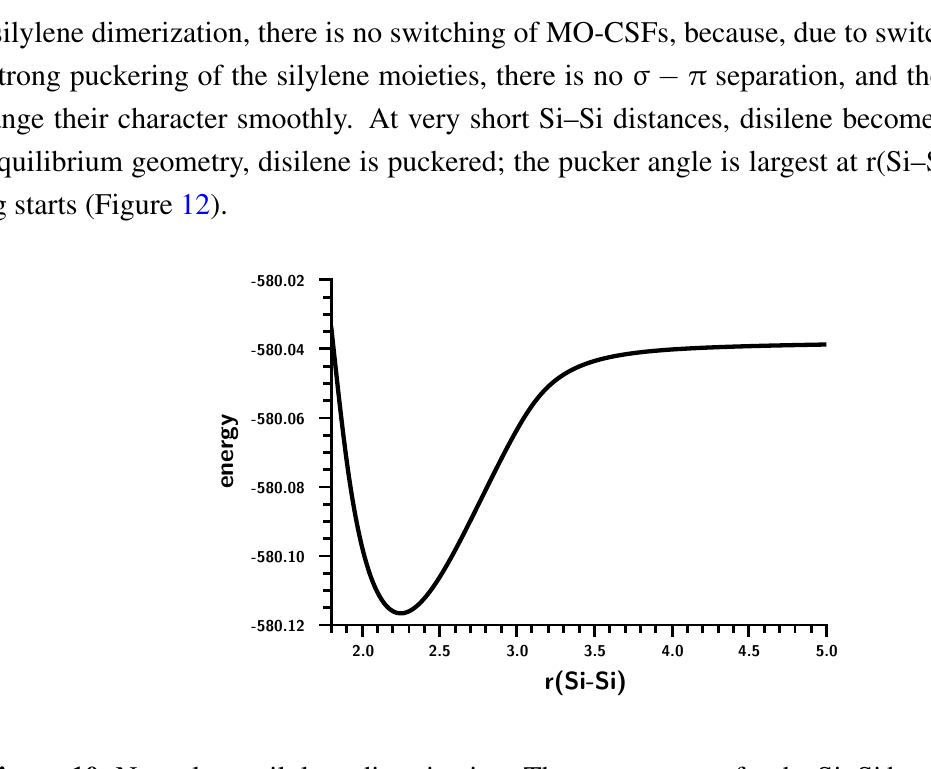
Figure 10. Non-planar silylene dimerization. The energy curve for the Si–Si bond stretching. Energy in Hartrees; bond length in Å.